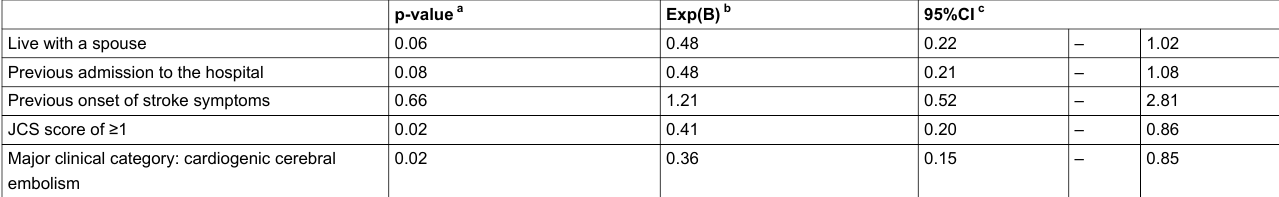
Table 2: Association between time of arrival to hospital from onset and patient characteristics: Multivariate analysis using data of all